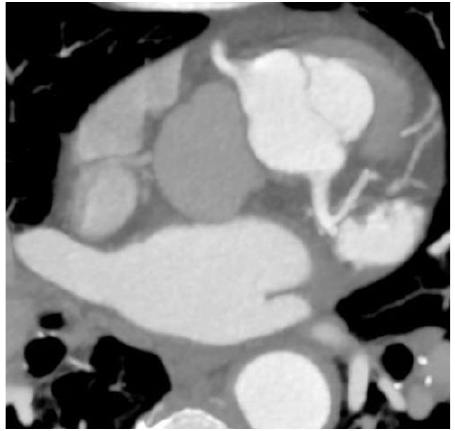
Figure 5. Congenital cardiac malformation with corrected transposition of the great arteries and abnormally rotated aortic cusps and origin of the coronary arteries. CCTA MIP oblique axial contrast-enhanced image at the aortic root shows congenital cardiac malformation with corrected transposition of the great arteries. The aorta is to the left of the pulmonary artery trunk; the aorta is in continuity with the left systemic ventricle, and the pulmonary artery is in continuity with the pulmonary ventricle. The malformation also involves aortic cusps that are abnormally rotated in the axial plane: two anterior sinuses, one on the right and one on the left, related to the patient, and a posterior one. The left main coronary artery arises from the posterior sinus, shows a posterior trajectory of 10 mm, and divides into the LAD and LCX. The LAD arises at a sharp angle and descends on the anterior face of the systemic ventricle. The RCA arises from the anterior right sinus and descends towards the anterior interventricular sulcus.